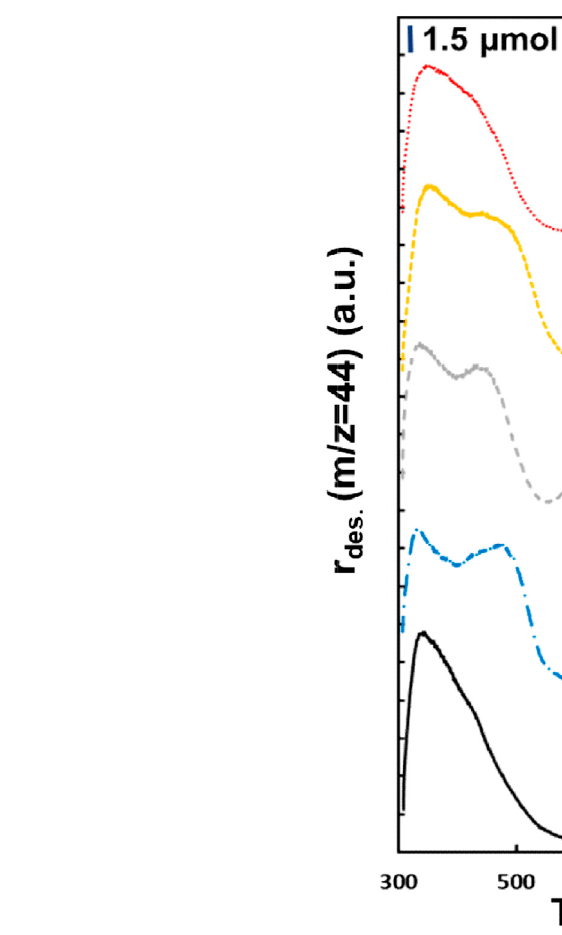
Frontiers in Chemical Engineering |